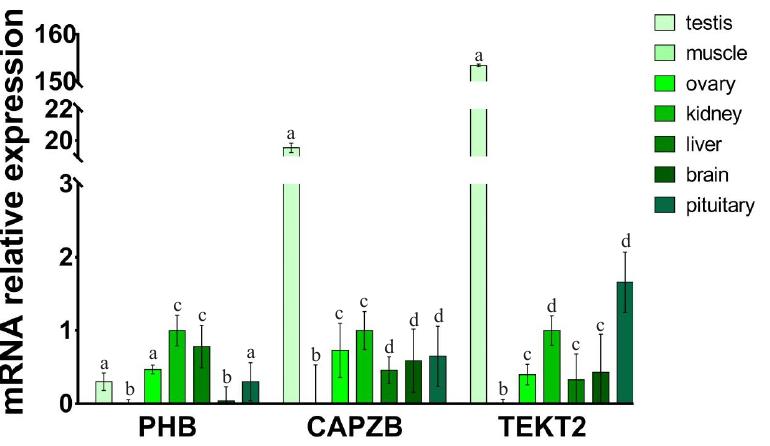
Figure 2. PHB (a), CAPZB (b), TEKT2 (c) mRNA expression in different tissues of Murrah buffalo. PHB, prohibitin; CAPZB, capping actin protein of muscle Z-line beta subunit; TEKT2, tektin-2. Data represent mean±standard deviation of three replicates, and the different superscripts in the same table indicate significant difference (p<0.05).